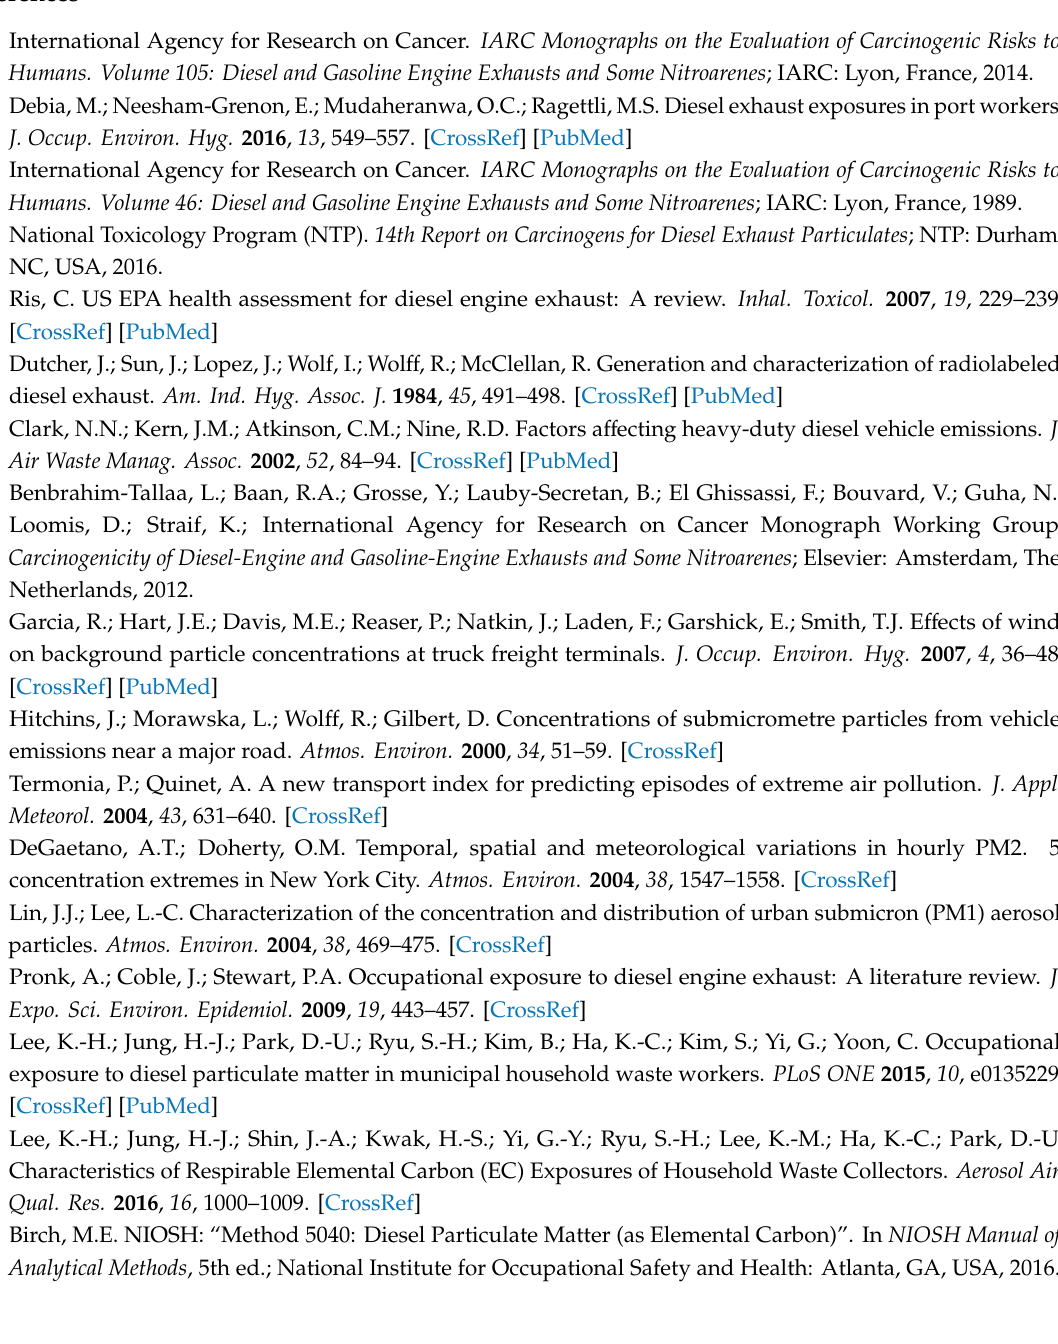
Table S1: Daily average wind speed data of research worksite by Beaufort wind scale in 2019, Table S2: Correlation coe ffi cients among EC, OC and TC by EC exposure